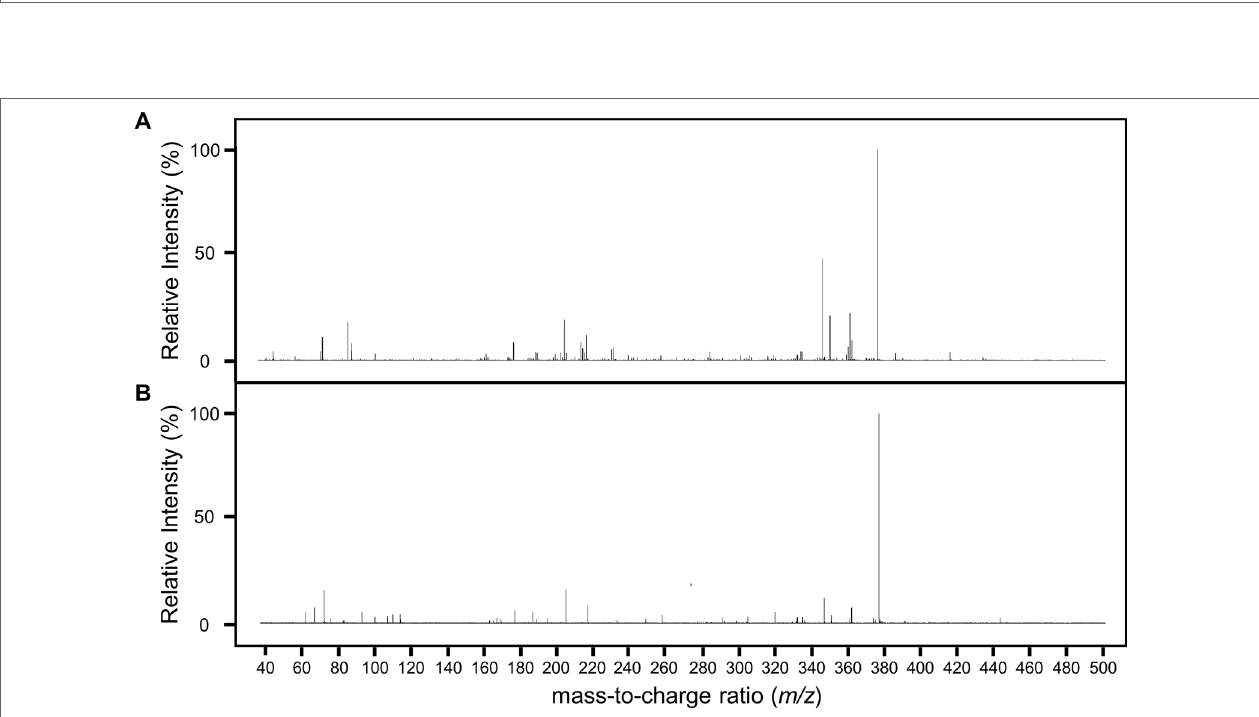
FIGURE 4 | Fragmentation analysis of NPC1161B standard and metabolite by LC-QToF-MS. Mass spectra for NPC1161B standard (A) and the metabolite identified from mosquito midgut extracts post-blood meal (B) after fragmentation at 42 eV. A number of peaks were found to be shared by both compounds (see Table 1